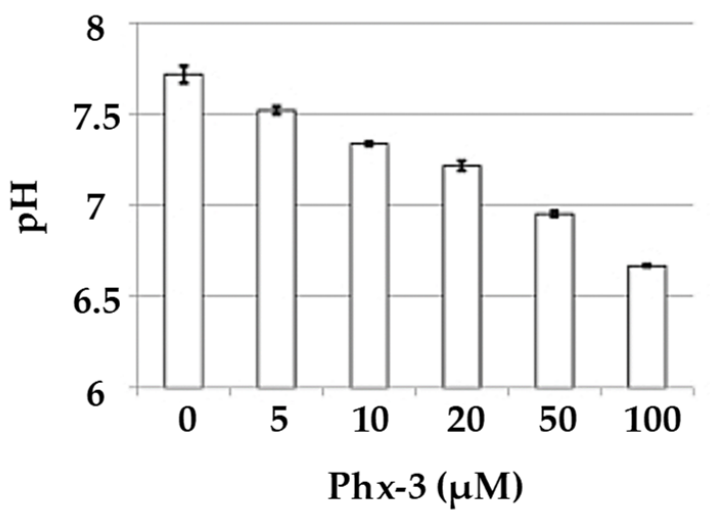
Figure 7. Changes in the pHi of MCF-7 cells treated with different concentrations of Phx-3 Source: reproduced from Che et al. [57] with permission from Proc. Japan Acad. Ser. B.